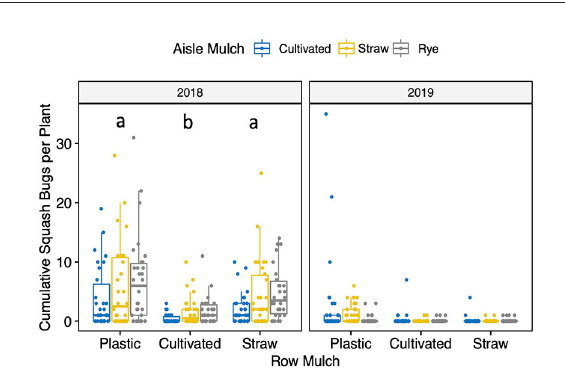
FIGURE4 Cumulative numbers of squash bugs per plant by row and aisle mulch, 2018 and 2019. Lowercase letters indicate significance groupings for row mulch across aisle mulch treatments within the same year. Groups with the same letter were not significantly different at p <